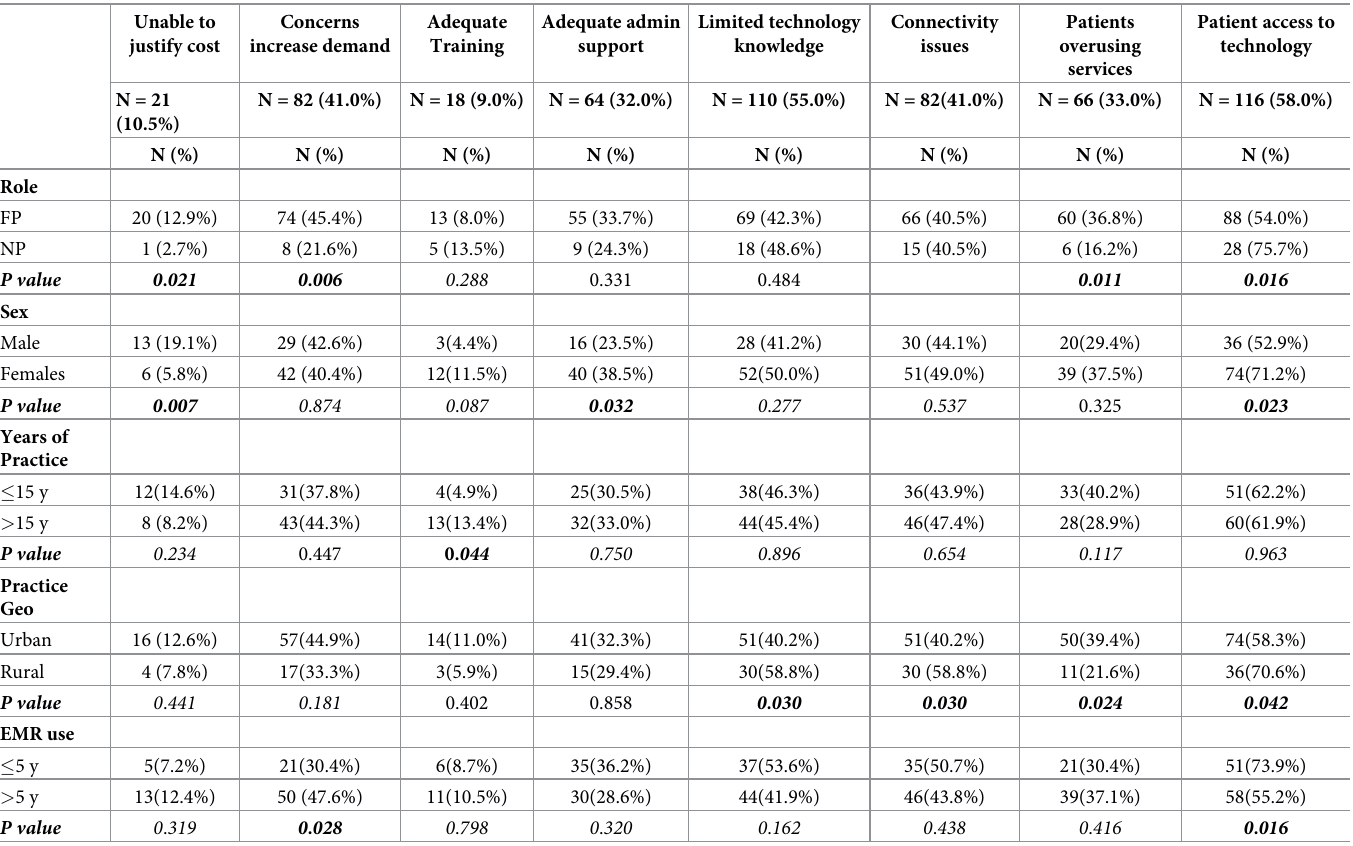
Table 4. Challenges to conducting virtual visits by the characteristics of